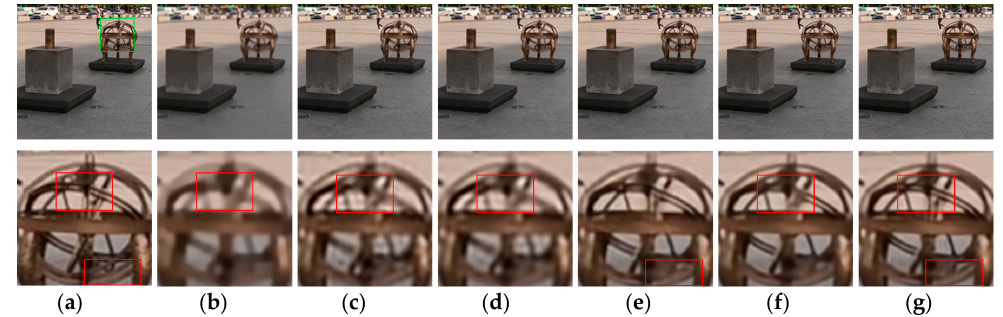
Figure 12. Deblurred results for test image with 17 × 17 Gaussian blur kernel of deviation 2.0. The first row shows the sharp image and deblurred images for the evaluated methods. The second row shows the enlarged views of the region marked with the green box in the original image and the deblurred images. ( a ) Original image [37]; ( b ) ECP; ( c ) EPLL; ( d ) NCSR; ( e ) SRN; ( f ) DPDNN; ( g ) proposed method.